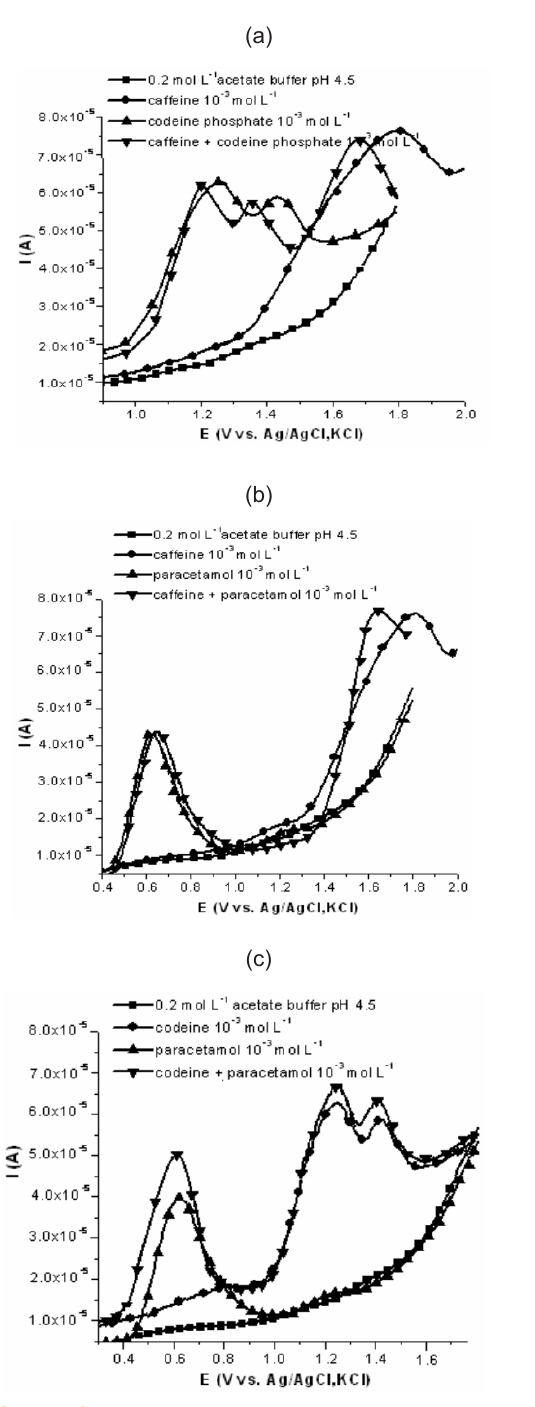
Figure 9. Square-wave voltammograms on electrochemically activated glassy carbon electrode for individual and simultaneous determination for (a) 10 -3 mol L -1 caffeine and codeine phosphate solutions; (b) 10-3 mol L -1 caffeine and paracetamol solutions; (c) 10-3 mol L -1 codeine phosphate and paracetamol solutions in